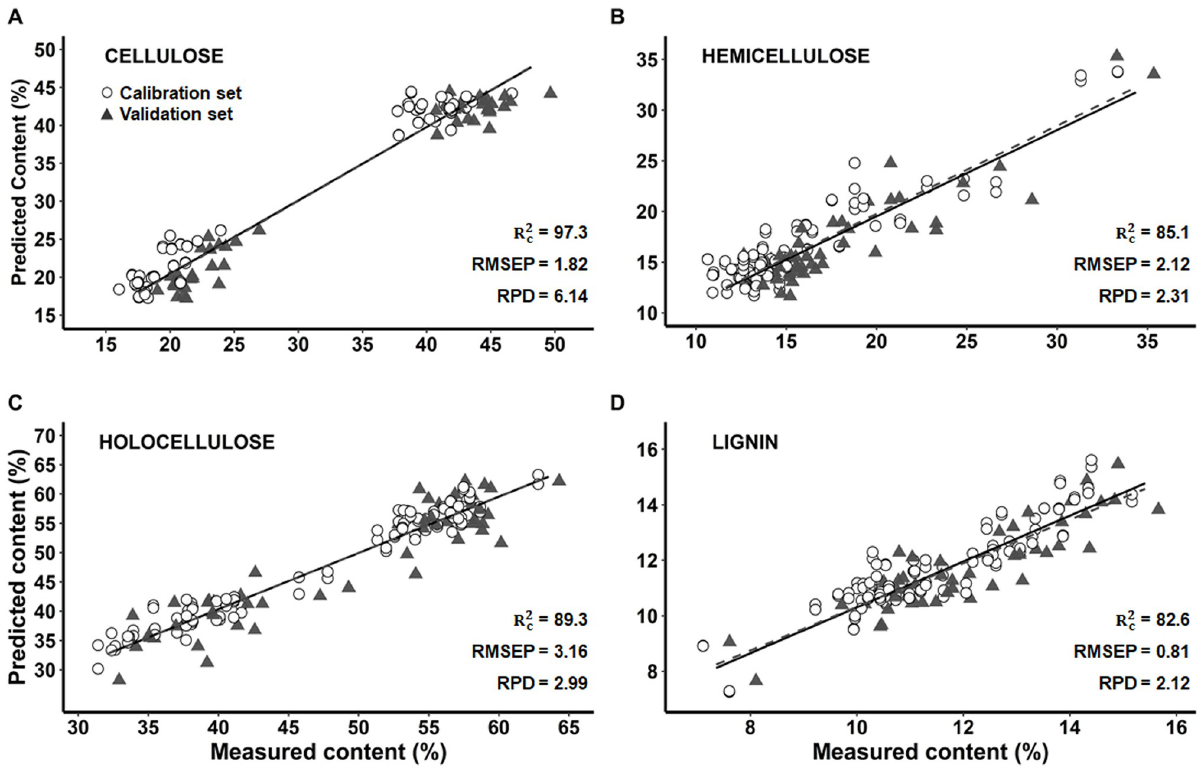
Fig 3. Prediction of cellulose, hemicellulose, hollocelulose and lignin content by multivariate models with FT-IR (PLS) in Bolaina ( G . crinita) . A: Cellulose, B: Hemicellulose, C: Holocellulose and D: Lignin. R 2 : coefficient of determination of calibration. RMSEP: root mean squared error of c predictions. RPD: ratio of performance to deviation.